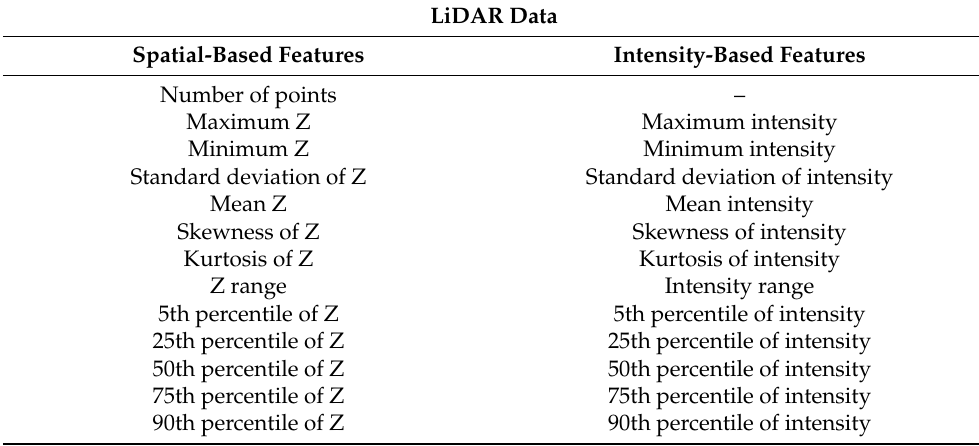
Table 1. The generated spatial- and intensity-based features from LiDAR data. LiDAR